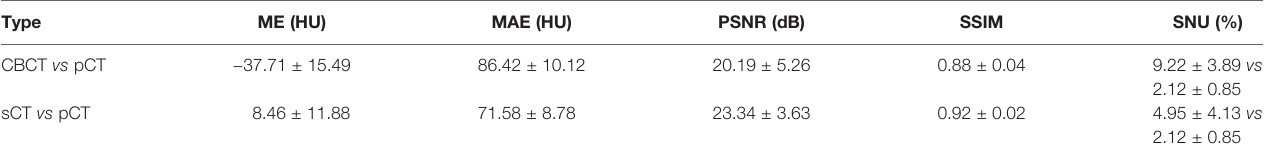
TABLE 2 | Similarity analysis between CBCT and pCT images, sCT and pCT images with all the testing patient datasets. Type